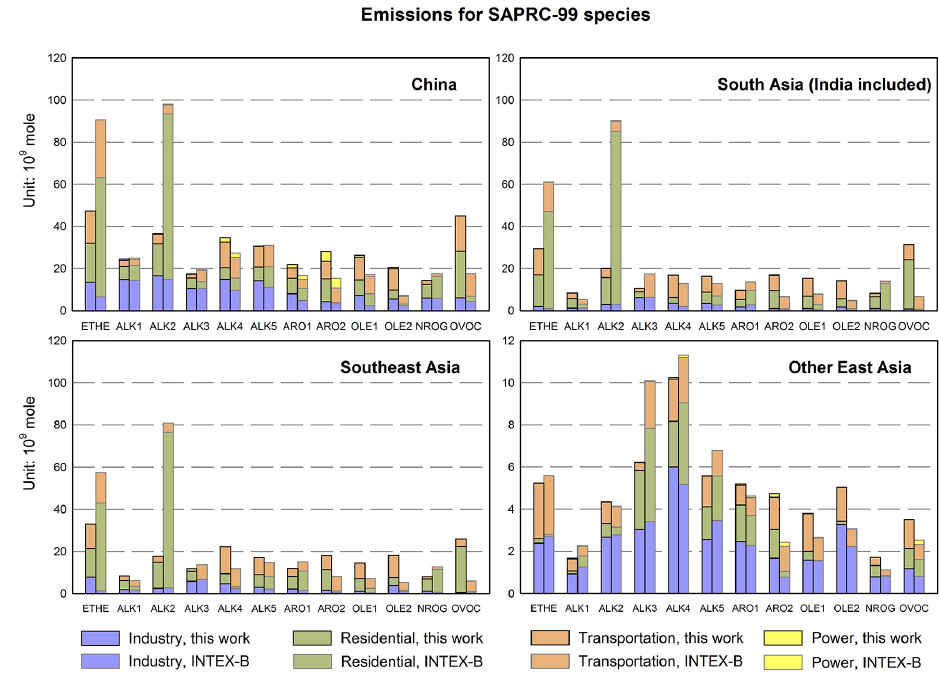
Figure 12. The 2006 Asian emissions for SAPRC-99 mechanism species by